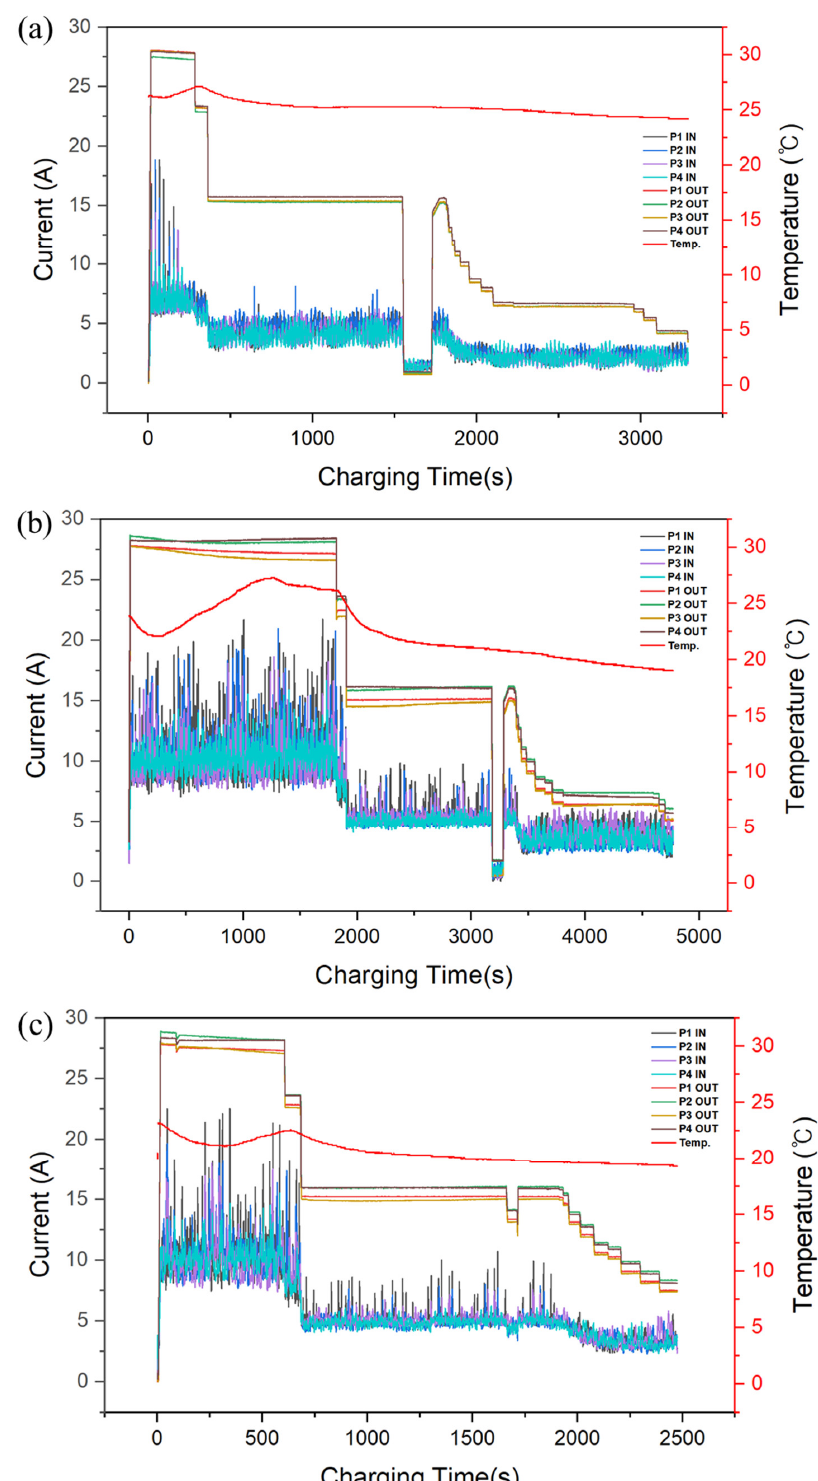
Figure 3. ( a ) Fast-charger normal charging pattern; ( b ) Power-module-aging charging pattern; ( c ) Cable-contact-failure charging pattern. (P1, P2, P3, P4 IN: No. 1, 2, 3, 4 power module input current, P1, P2, P3, P4 OUT: No. 1, 2, 3, 4 power module output current, Temp: Temperature).